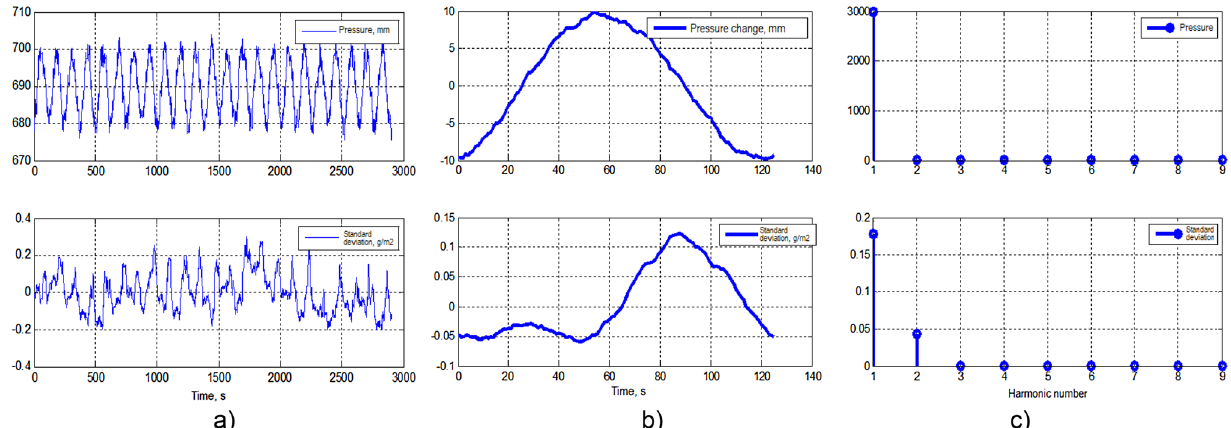
chronous accumulation of input and output signals; c results of harmonic analysis of input and output